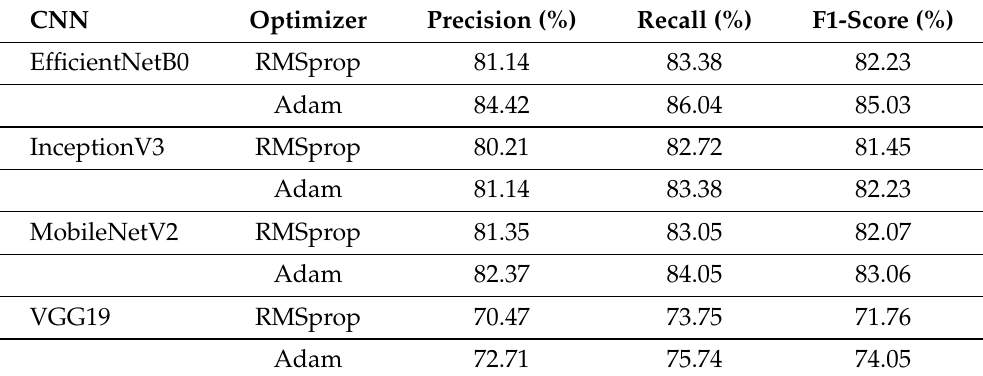
Table 5. Precision, recall and F1-score obtained on the training set, validation set and test